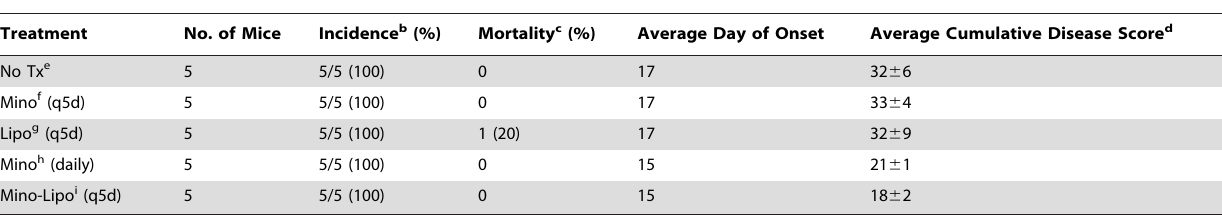
Table 1. Summary of the EAE disease course a .